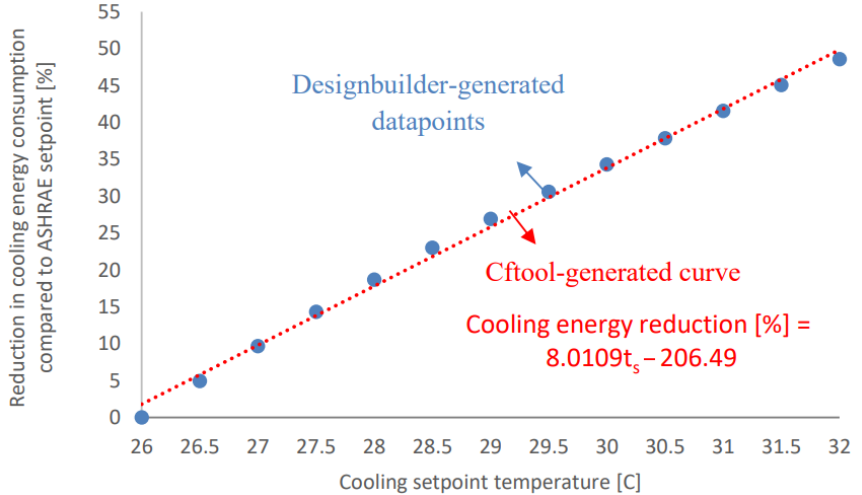
Figure 5. Energy reduction percentage for each cooling temperature setpoint with respect to the ASHRAE criteria.